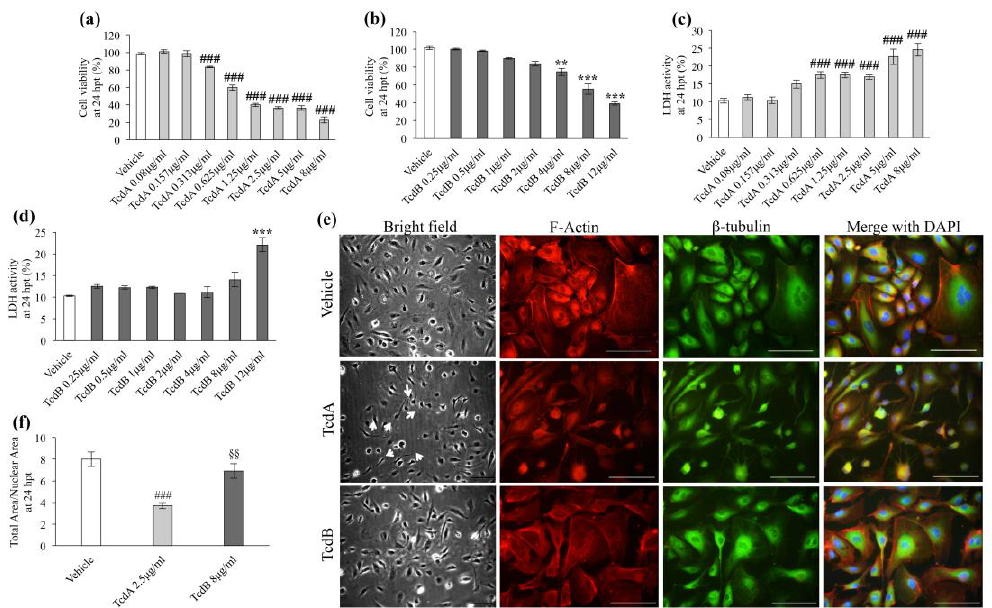
Figure 5. C. difficile toxins induce different effects on the morphology of human umbilical vein endothelium cells (HUVEC). ( a ) Cell viability, evaluated by MTT assay, in HUVEC cells treated with vehicle and increasing doses of TcdA. Data, normalized to vehicle, are represented as the mean ± SEM. ( n = 6), ( ### p < 0.001 compared to vehicle. ( b ) Cell viability, evaluated by MTT assay, in HUVEC cells treated with vehicle and increasing doses of TcdB. Data, normalized to vehicle, are represented as the mean ± SEM. ( n = 6), (*** p < 0.001, ** p < 0.01 compared to vehicle. ( c ) Analysis of lactate dehydrogenase LDH activity on the supernatant of TcdA-treated HUVEC cells. Data, normalized to Triton X-100-treated cells, are represented as the mean ± SEM ( n = 6), ( ### p < 0.001 compared to vehicle). ( d ) Analysis of lactate dehydrogenase (LDH) activity on the supernatant of TcdB-treated HUVEC cells. Data, normalized to Triton X-100-treated cells, are represented as the mean ± SEM ( n = 6), (*** p < 0.001 compared to vehicle). ( e ) Representative images of HUVEC treated with vehicle, 2.5 g/mL TcdA or 8 g/mL TcdB for 24 h. Images of cellular morphology are taken in bright field (left) Scale bar = 50 µm. In the middle of the panel, images in red and green represent the F- actin and the β -tubulin staining, respectively. On the right, the merge of the red and green fields with DAPI (blue) was shown. Images were acquired with a Leica DM-2000 microscope. Scale Bar = 50 µm. ( f ) HUVEC cells rounding, expressed as the ratio of total to nuclear area, 24 h after addition of vehicle, 2.5 g/mL TcdA and 8 g/mL TcdB. Data are represented as the mean ± SEM ( n = 20), ( ### p < 0.001 compared to vehicle, §§ p < 0.01 compared to 2.5 g/mL TcdA).